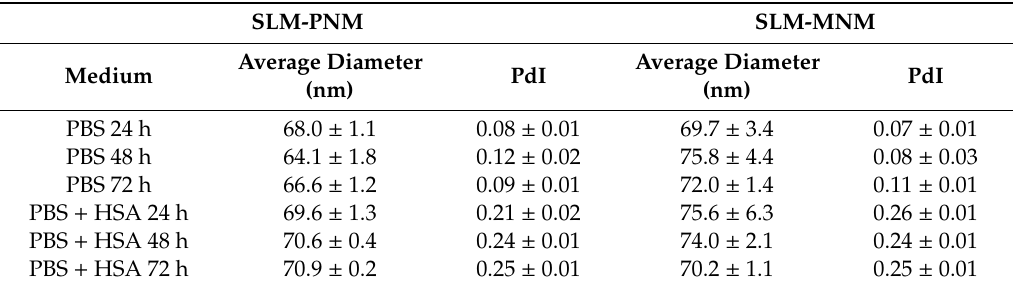
Table 6. Physical stability of SLM-loaded nanomicelles in phosphate bu ff er saline (PBS) without and with HSA (Mean ± SD, n =